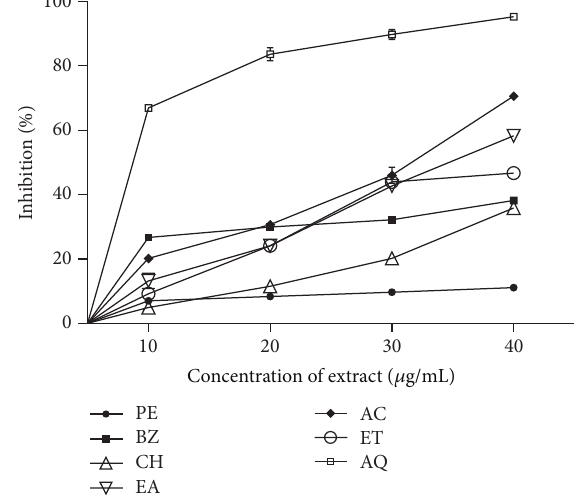
Figure 2: Metal ion chelating activity of T. cordifolia stem extracts. Phytochemicals present in sample were extracted with petroleum ether (PE), benzene (BZ), chloroform (CH), ethyl acetate (EA), ace- tone (AC), ethanol (ET), and water (AQ) as described in Section 2. Metal ion chelating activity of extracts was measured at different concentrations (10–40 𝜇 g/mL) and absorbance was recorded at 562 nm. The results are expressed as mean ± SD of three replicates ( 𝑃 < 0.05